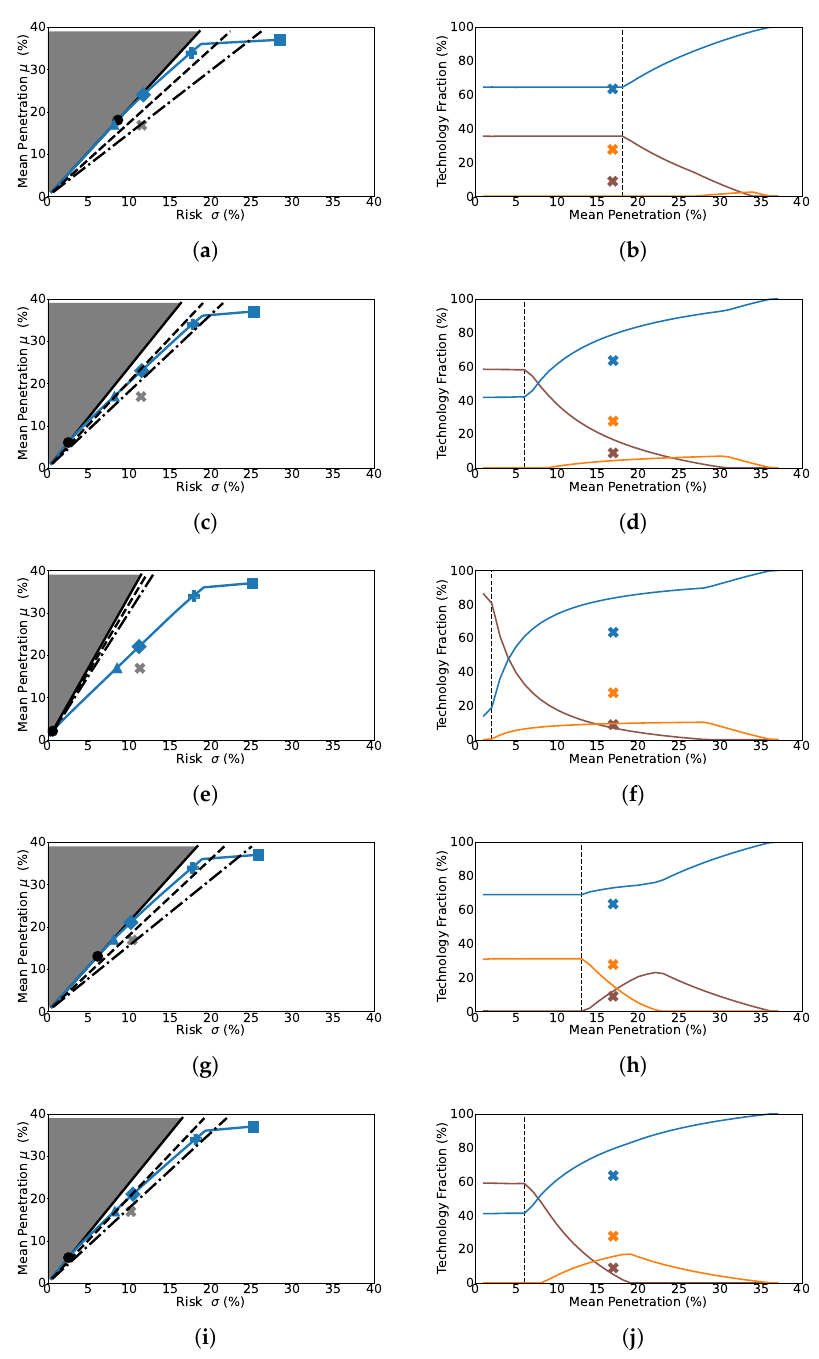
Figure 4. ( Left ) Approximations of the optimal fronts with the risk, σ global/technology/base , in abscissa and the mean penetration (1), µ , in ordinate. White (resp., gray) areas to the right (resp., left) are not Pareto optimal (resp., not feasible). Particular mixes are depicted: the “2018 actual solar-wind mix” (gray cross); the “penetration-as-actual mix” (blue triangle) with lower risk; the “risk-as-actual mix” (blue diamond) with higher penetration; the “cost activation mix” (black dot) with the largest penetration for which the maximum-cost constraint is not active; the “cost-activated mix” (blue plus) with moderate penetration compared to the “maximum-penetration mix” (blue square), in which the cost constraint is activated; ( Right ) Shares of wind (blue line), PV-BES (brown line) and CSP/CSP-TES (orange line) capacities versus the mean penetration for the global strategy with maximum-cost constraint (5). The crosses represent the shares for the actual mix. ( a , b ) PV-ILR2-Wind-CSP-SM1; ( c , d ) PV-ILR3-Wind-CSP-SM1; ( e , f ) PV-ILR4-Wind-CSP-SM1; ( g , h ) PV-ILR2-Wind-CSP-TES SM2; ( i , j ) PV-ILR3-Wind-CSP-TES